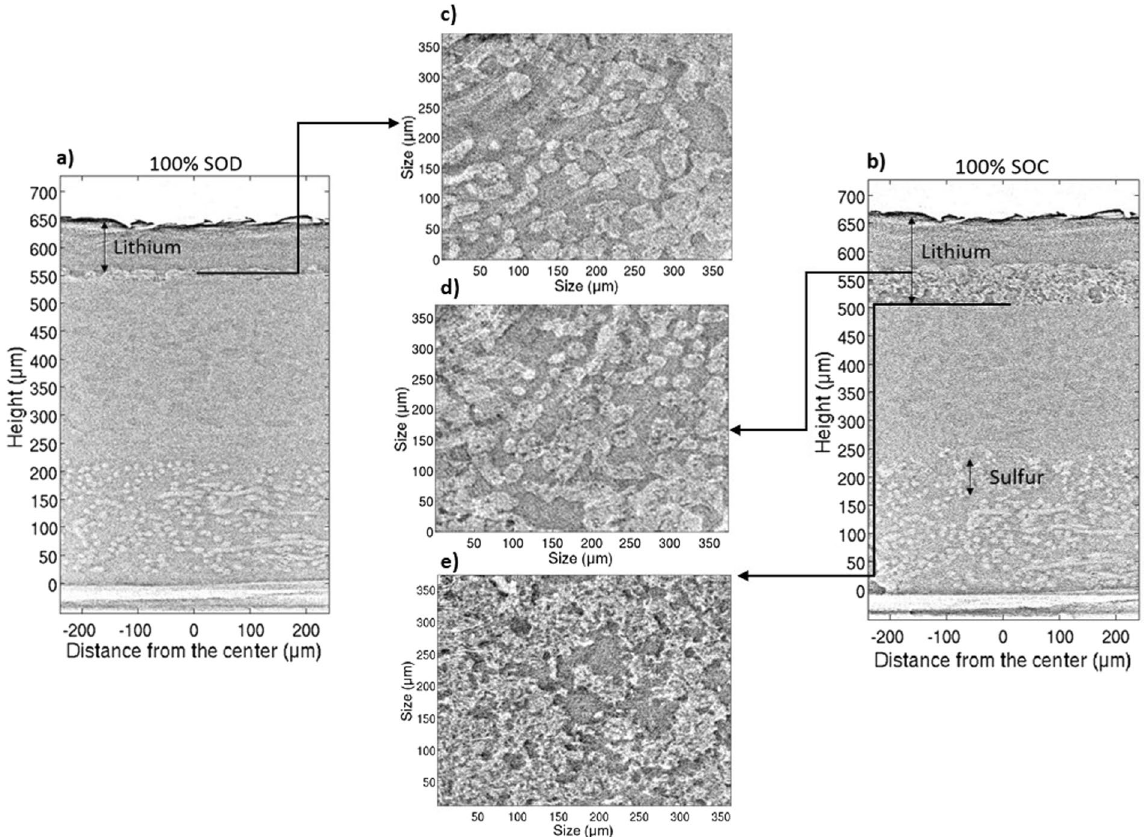
Figure 3. ( a ) Vertical slice of the cell at the end of the first discharge (100% SOD). ( b ) Vertical slice of the cell at the end of the first charge (100% SOC). ( c ) Horizontal slice of the cell at 100% SOD at 560 µ m height. ( d ) Horizontal slice of the cell at 100% SOC at 570 µ m height. ( e ) Horizontal slice of the cell at 100% SOC at 505 µ m